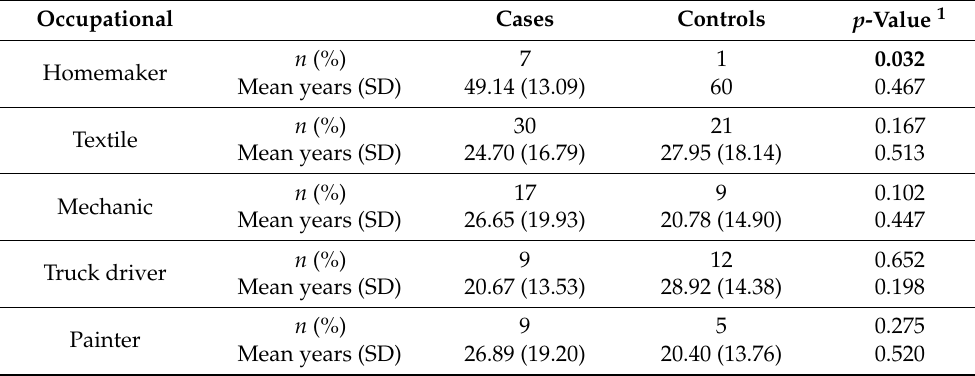
Table 4. Comparison between cases and controls of the different types of occupation and the years